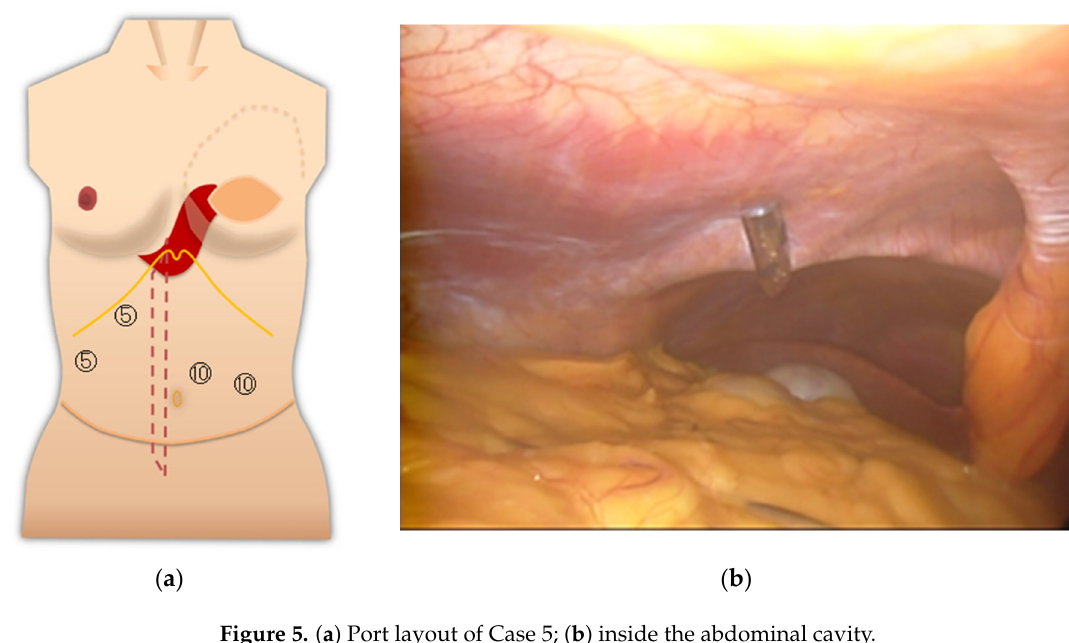
Figure 5. ( a ) Port layout of Case 5; ( b ) inside the abdominal cavity.